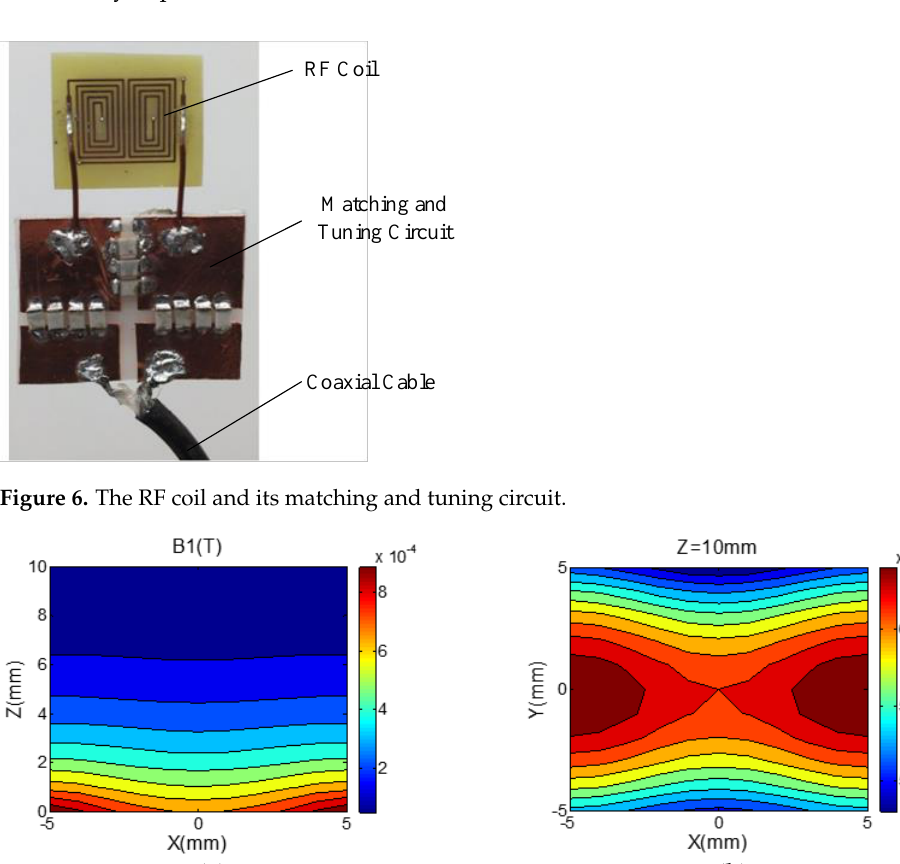
Figure 7. ( a ) Measured 𝐵 1 strength in ROI on transverse sections. ( b ) Measured 𝐵 1 strength in ROI on longitudinal sections.